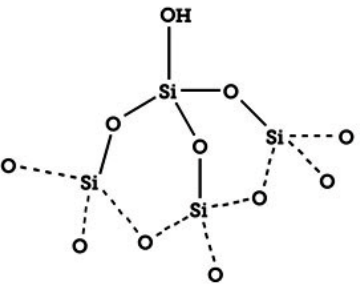
Figure 5. The tetrahedral network structure of SiO 4.